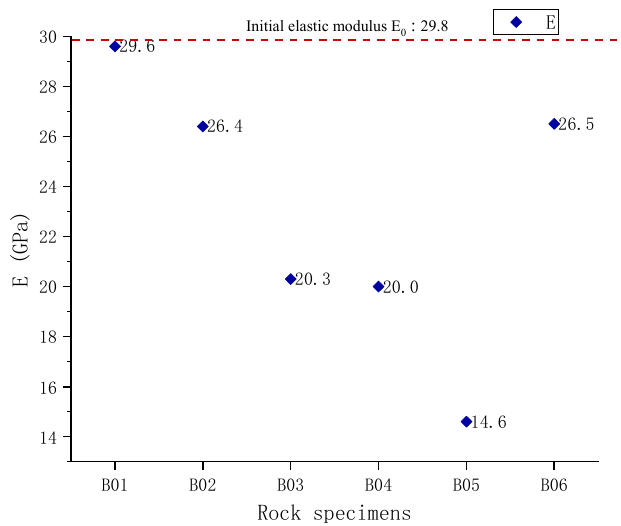
Figure 15. Relationship between final cycle elastic modulus and initial elastic modulus of rock sample.